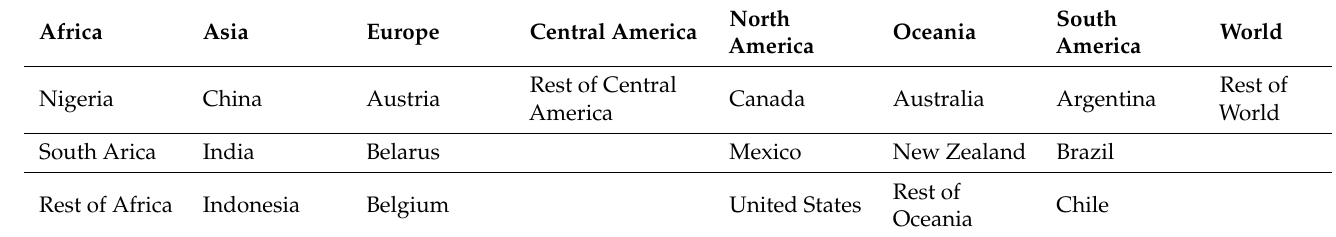
Table A2. Countries and regions represented in FOROM in the current